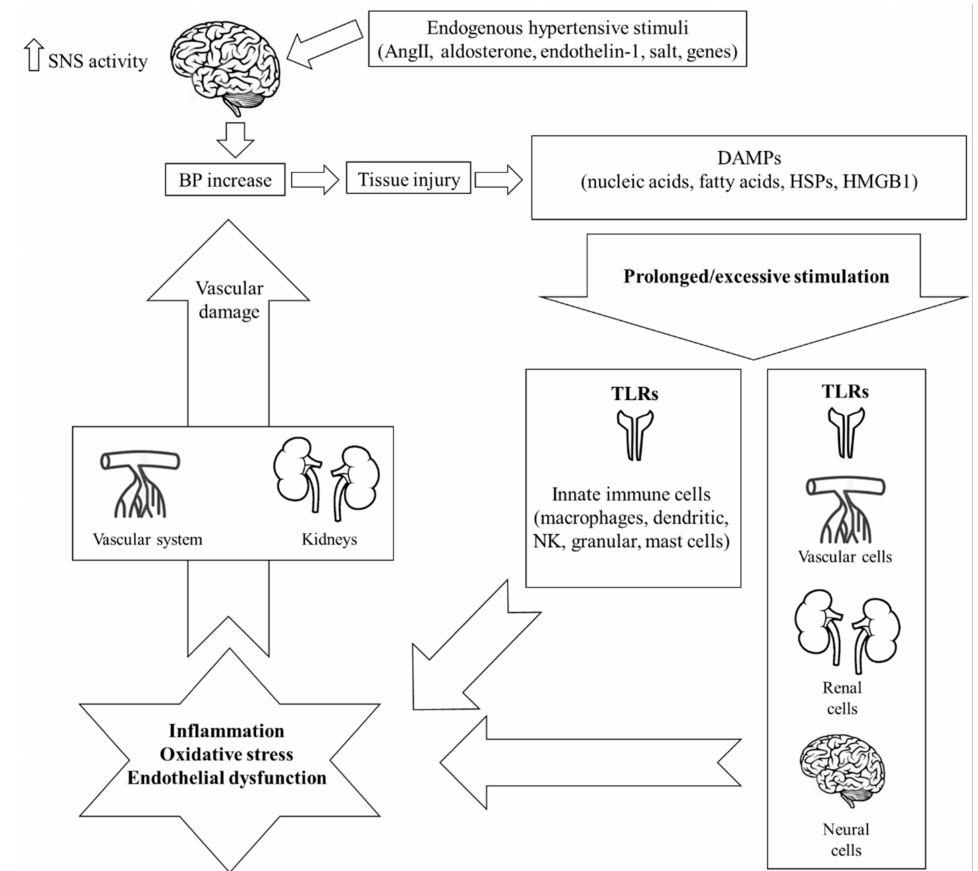
Figure 1. Schematic representation of the mechanisms of innate immunity implicated in the pathogen- esis of hypertension. Endogenous stimuli including angiotensin II (AngII), aldosterone, endothelin-1, salt, and several genes initially increase central nervous signaling and thus sympathetic nervous system (SNS) activity, which, in turn, provokes a slight elevation in blood pressure (BP). This event leads to tissue injury and the release of endogenous intra- or extracellular molecules including cell-derived nucleic acids, fatty acids, heat shock proteins (HSPs), and high-mobility group box-1 (HMGB1), all termed damage-associated molecular patterns (DAMPs). In the hypertensive envi- ronment, an excessive or prolonged DAMP-mediated stimulation of innate immunity leads to an aberrant immunologic response through the activation of toll-like receptors (TLRs). The result is chronic low-grade inflammation, oxidative stress, and endothelial dysfunction, all of which inflict damage on the kidneys and the vascular system, thus further increasing BP. Importantly, increased TLR expression and subsequent activation has been documented not only on immune but also on non-immune cells of the central nervous, renal, and vascular system, all major contributors in the pathogenesis of